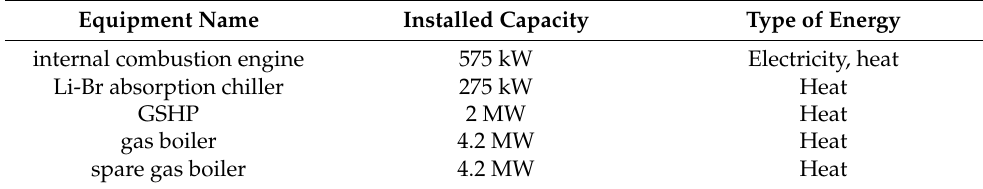
Figure 1. Equipment composition of IES. Table 1. Equipment parameters of IES.